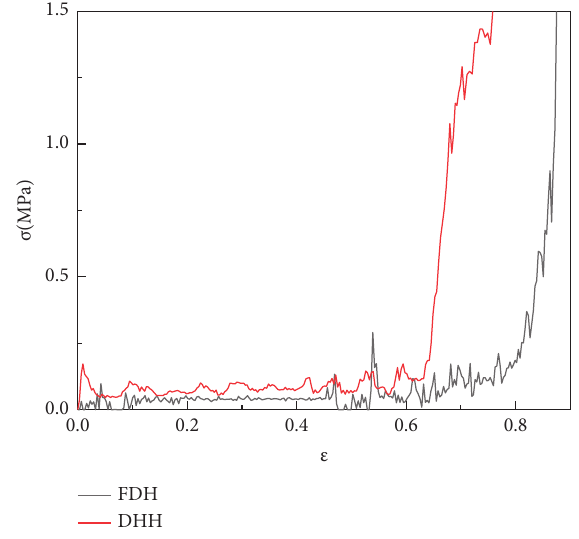
Figure 4: FE prediction of the quasi-static collapse response of the DHH and the FDH, N � 12 and ρ �